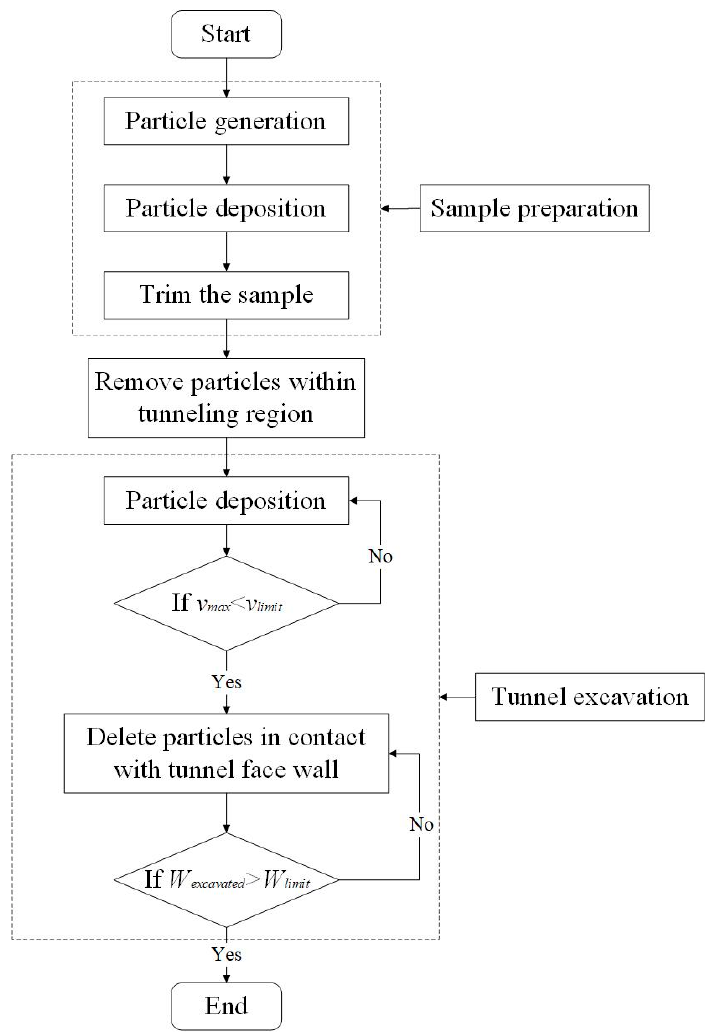
Figure 13. Flow chart for the computational process ( v max : the maximum velocity of the particles; v limit : velocity limit which is close to zero; W excavated : total weight of the removed particles; and W limit : weight limit for the deposition calculation in tunneling simulation).